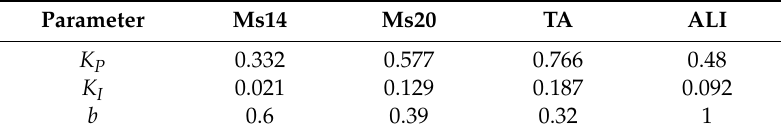
Table 7. PI controller parameters for Case 2.